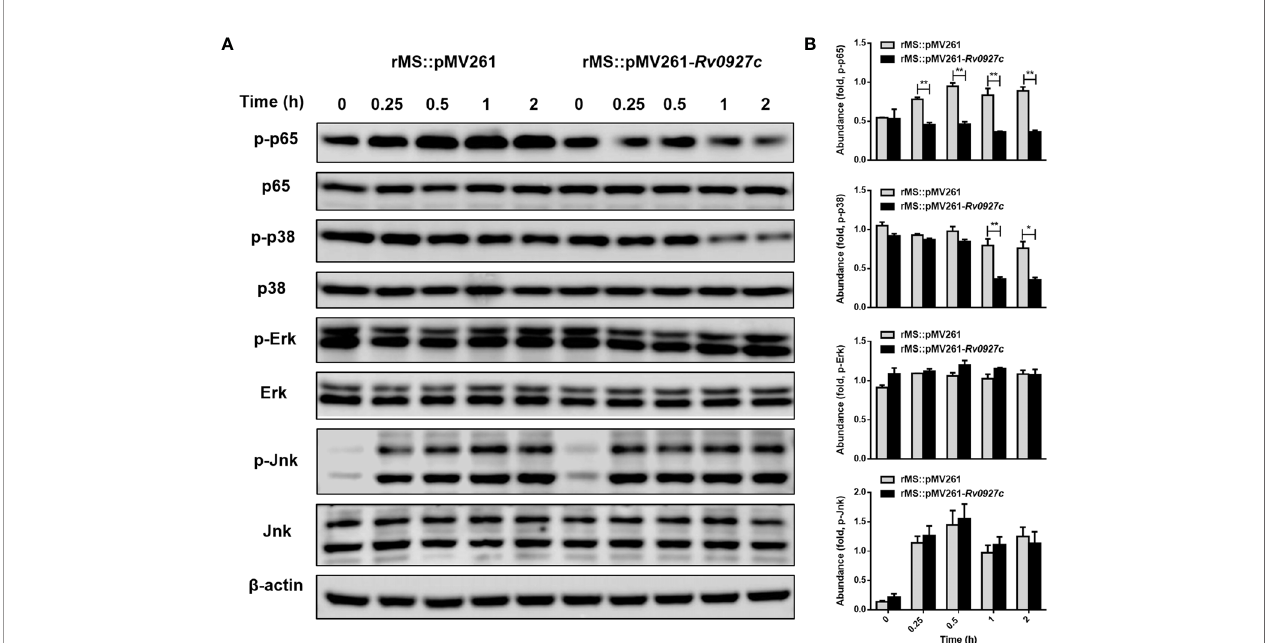
FIGURE 3 | Rv0927c suppresses the activation of MAPK and NF- k B pathways upon mycobacterial infection. (A) Immunoblot analysis of phosphorylated p65, p38, Jnk, Erk, and total b -actin in RAW264.7 cells infected for 0 – 2 h with rMS::pMV261 and rMS::pMV261- Rv0927c . (B) Densitometry quanti fi cation of results for (A) presented relative to those of b -actin. * P < 0.05 and ** P < 0.01 (unpaired two-tailed Student ’ s t test). Data are representative of one experiment with two independent biological replicates (mean and sem of n = 3 cultures).